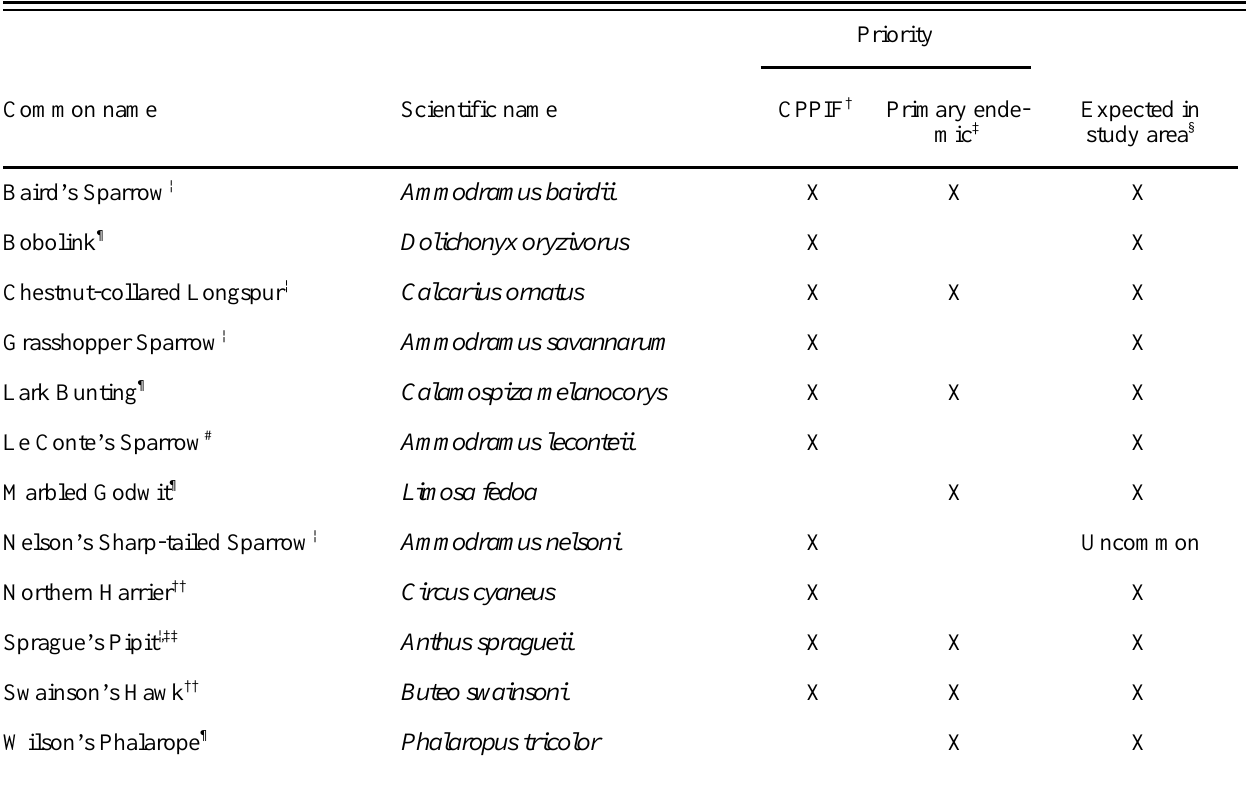
Table 1. Status and expected occurrence of 12 endemic grassland bird species of high conservation priority that were present in all three predicted waterfowl breeding density strata (low, < 8 pairs/km²; medium, 8– 15 pairs/km²; high, > 15 pairs/km²) and detected on > 20% of survey routes in southern Saskatchewan in 2001 and